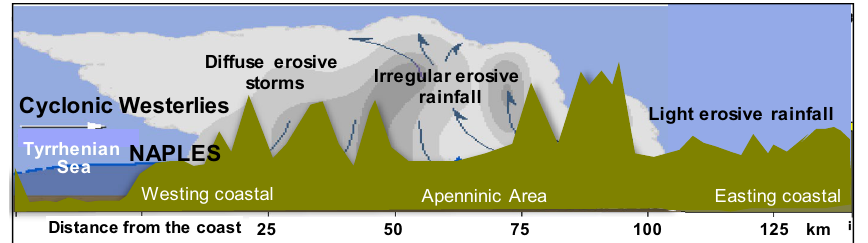
Figure 2. Scheme depicting the erosive rainfall pattern with cyclonic westerlies across a longitudinal transect west–east up to the middle Apennine of Italy. The city of Naples is shown, situated on the western coast of southern Italy (40° 50 ′ N, 14° 15 ′ E).